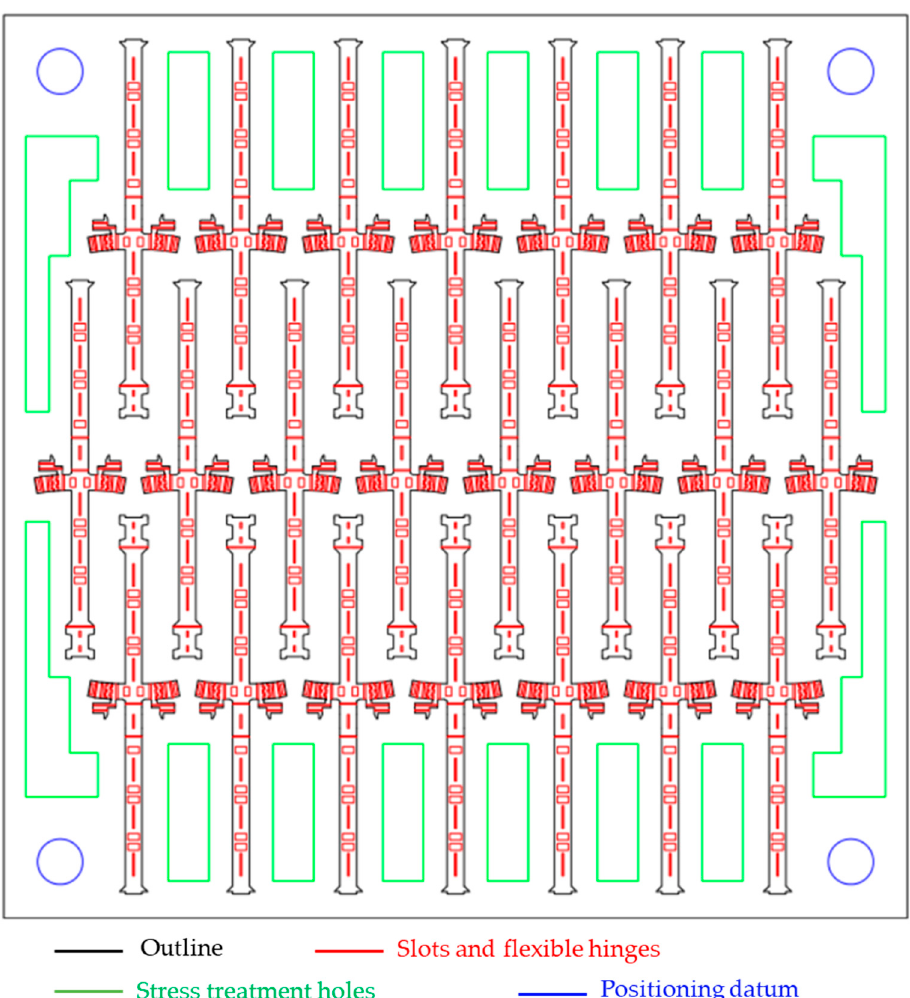
Figure 10. Design drawings for batch processing with a size of 80 mm × 80 mm.